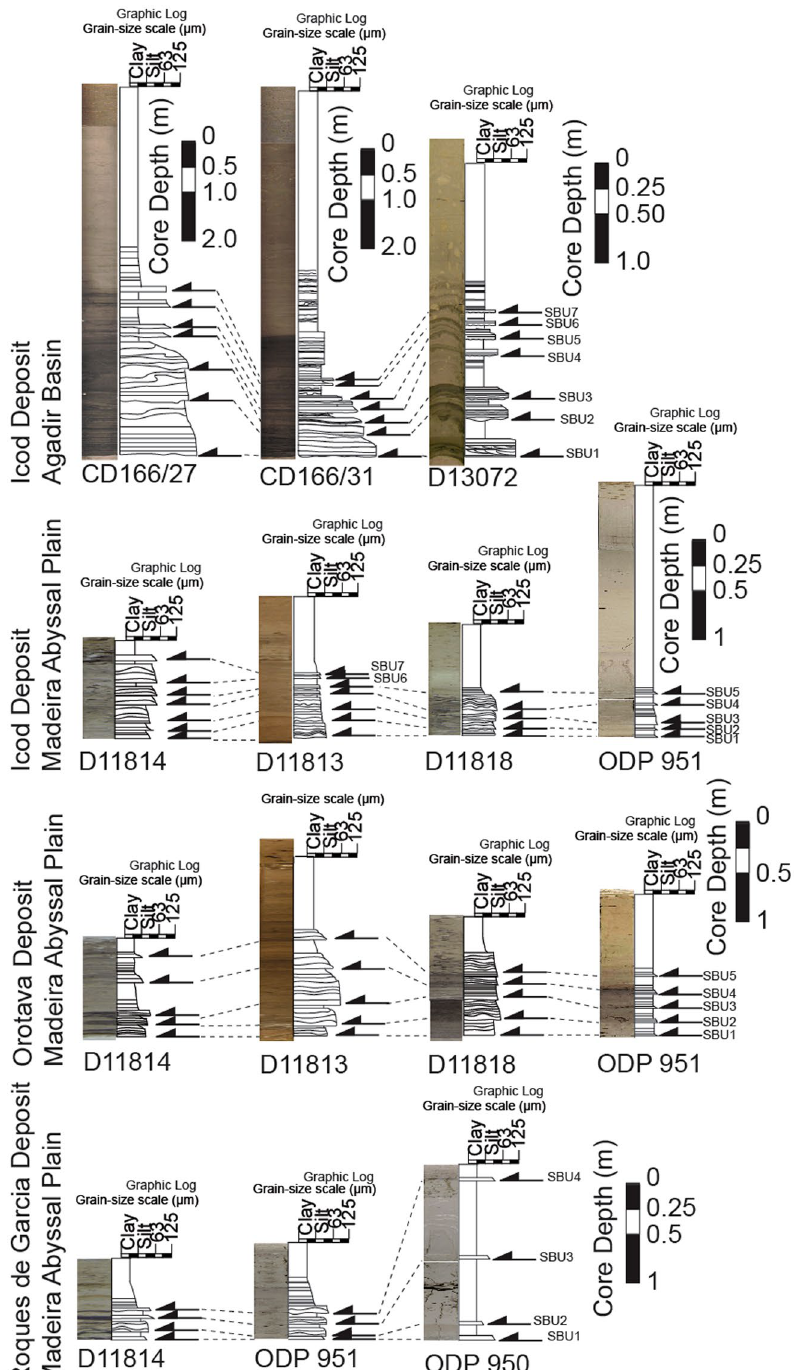
Figure 3. Deposits from the Icod, Orotava and Roques de Garcia landslides from Tenerife recovered from the Agadir Basin and Madeira Abyssal Plain. Deposits show the presence of subunits, with multiple fining-upwards sands that are amalgamated proximally but form discrete sand-mud couplets distally. Distally from source these individual turbidite sub-units are separated by 5–75 cm of turbidite mud representing fine suspension fallout that has settled and consolidated between the flows of each failure stage. SBU stands for